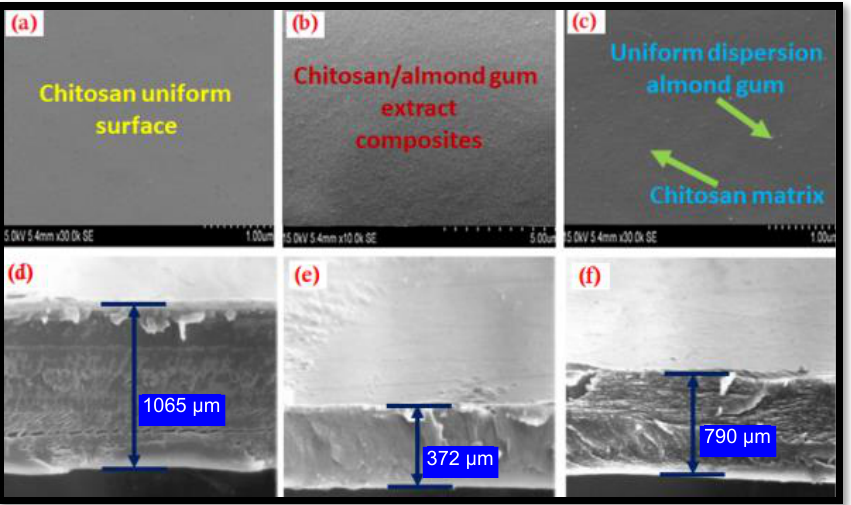
Figure 2. SEM micrographs of the ( a ) chitosan, ( b , c ) chitosan/almond gum extract composites; ( d – f ) the cross-section images of test samples. The chitosan and almond gum components are shown as green color arrows on the CSA composite film surface. The SEM cross-section images of the CSA films and chitosan film are represented by the blue-hued arrows.